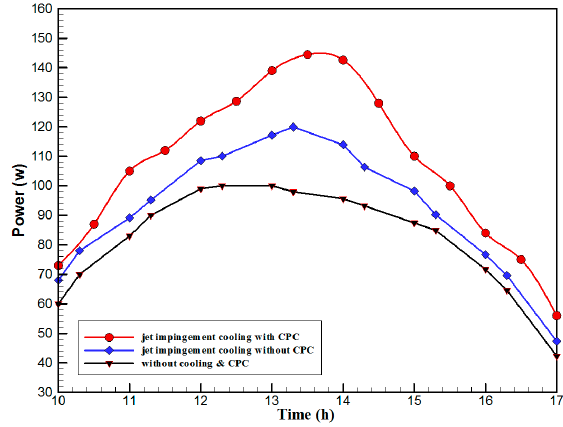
Figure 10. The hourly variation of electrical output power for the PVT-CPC collector, PVT without CPC and the PV module.